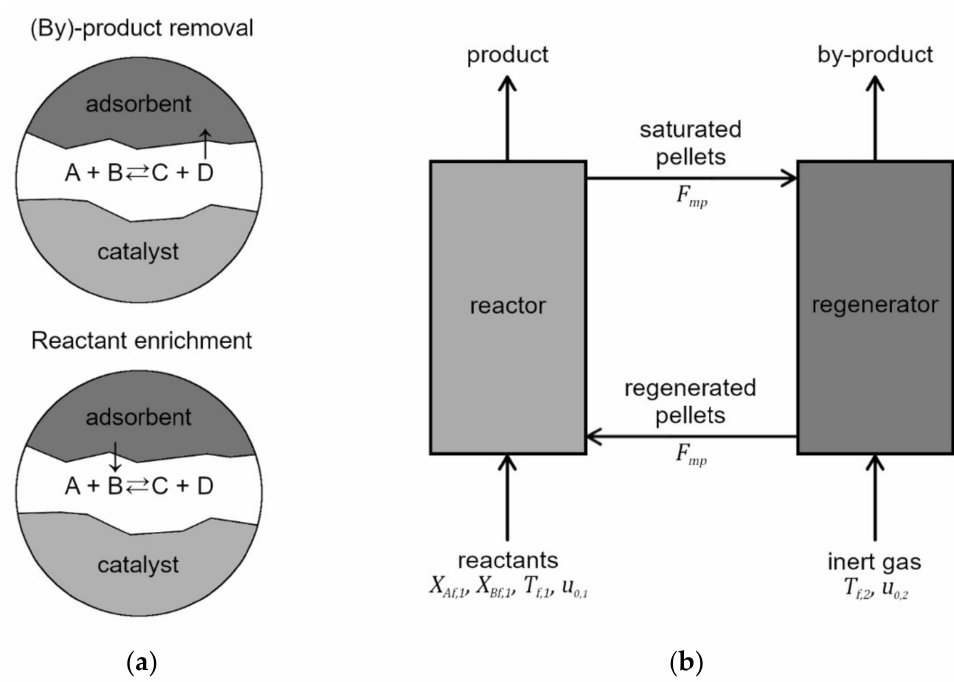
Figure 1. Adsorptive reactors: ( a ) schematic principle of adsorptive reactor for enhancing conversion; ( b ) scheme of a dual fluidized-bed reactor–regenerator